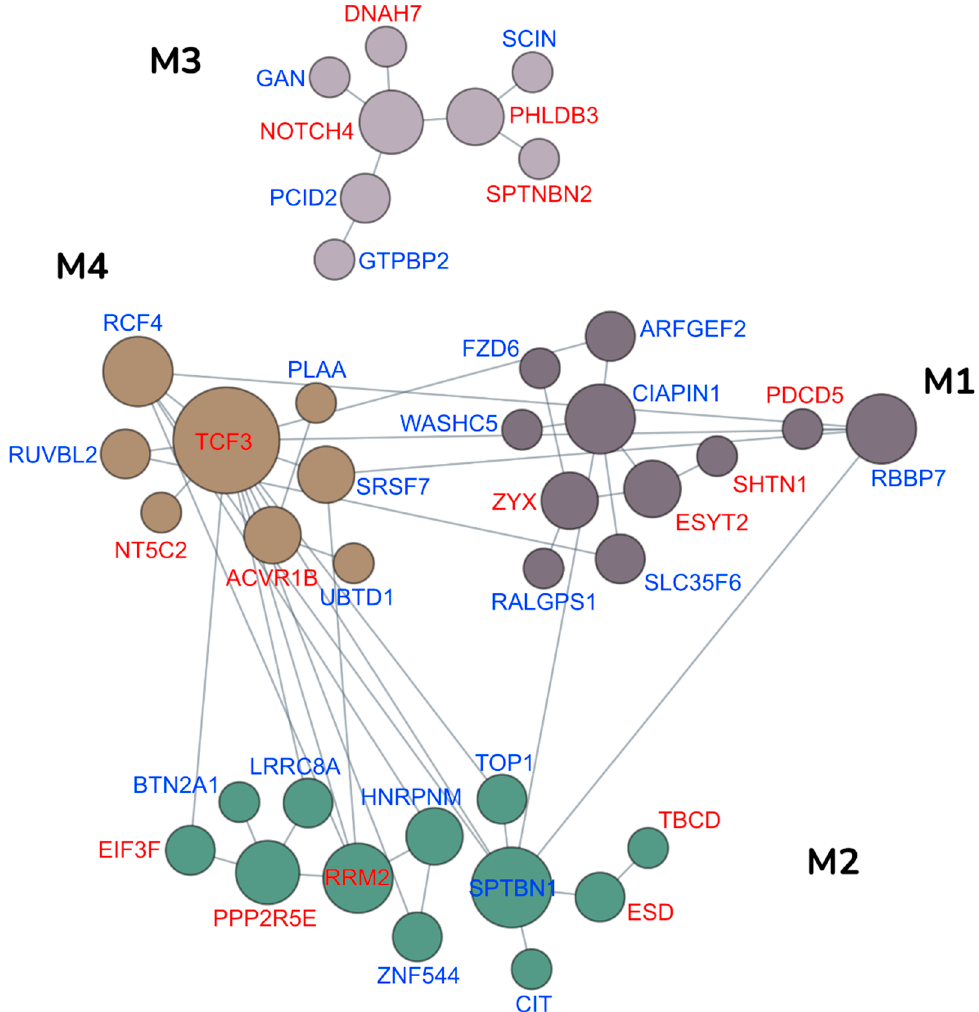
Figure 4. Functional networks of Tz modulated proteins in EVs released from SKBR-3 cells. The biological processes associated with the Tz modulated protein signature associated with EVs released from SKBR-3 cells proteins were characterized by projecting these signature proteins onto mammary epithelium-specific functional networks at HumanBase (https://hb.flatironinstitute.org, accessed on 11 March 2021). These network modules represent genes and their interactions in biological processes and pathways active in mammary epithelium. The most representative biological processes enriched within each module are as follows: M1 mitochondrial membrane organization, M2 mitotic cytokinesis, M3 negative regulation of organelle organization, and M4 cellular response to lipid. The protein expression is represented by the color scheme in which blue and red protein symbols indicate high and low expression of the corresponding proteins in EVs from Tz treated cells, respectively. The diameter of a node corresponds to the number of connections to other nodes.